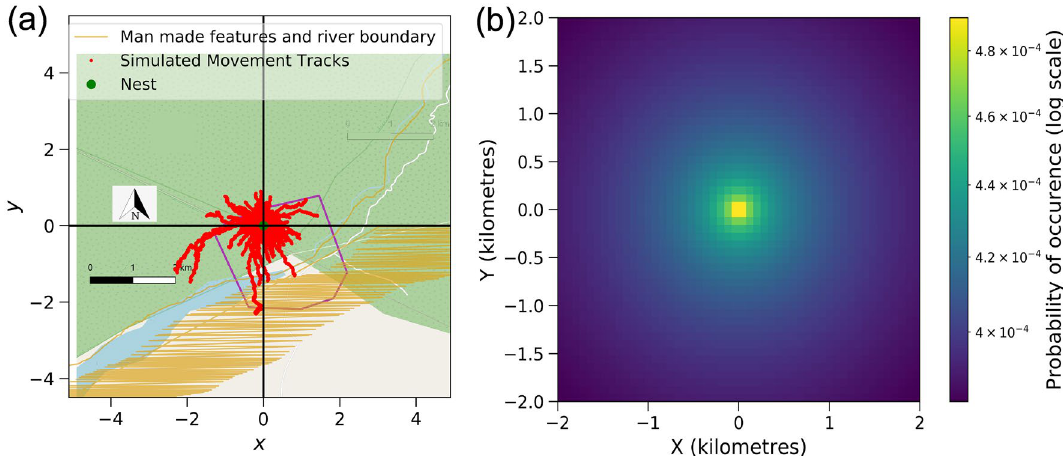
Figure 2. ( a ) Simulated movement points for breeding Great hornbill GH1Br generated with 7500 time steps from the Langevin equation. ( b ) Corresponding probability map of spatial use from Fokker–Planck equation. Also see Supplementary video SI Fig